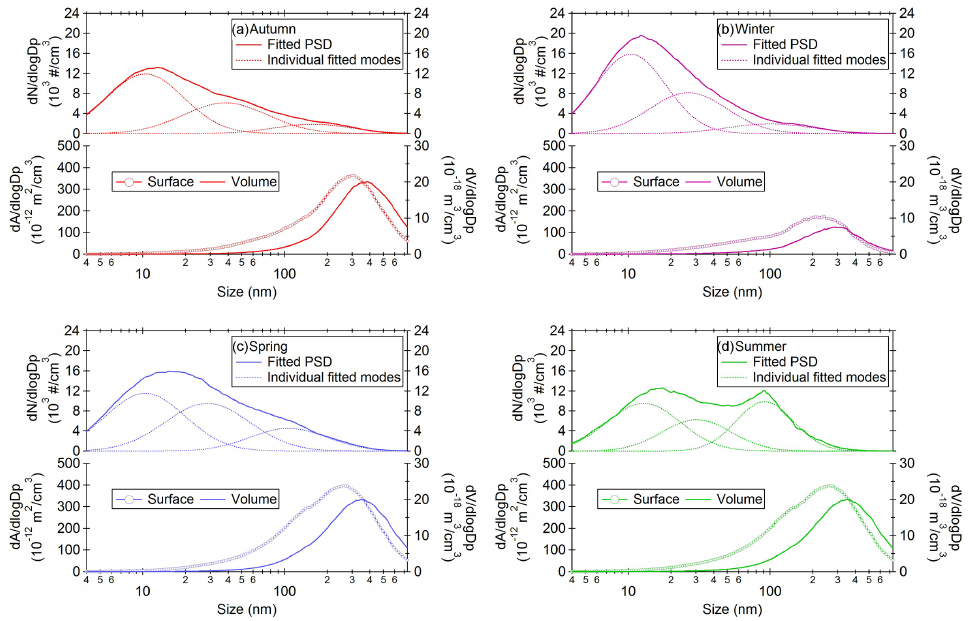
Figure 2. Size distribution of particle number (upper panel), and surface and volume (lower panel) concentrations measured in (a) autumn, (b) winter, (c) spring and (d) summer (by curve